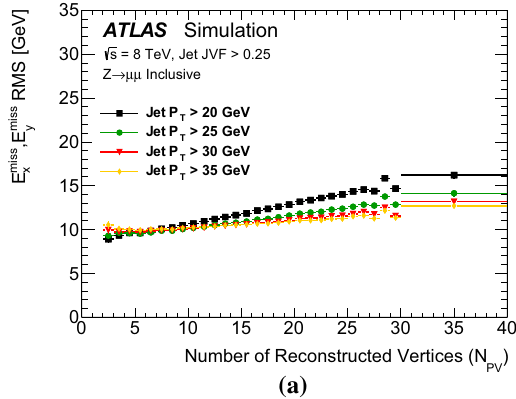
Fig. 19 The a TST E miss resolution as a function of the number of T reconstructed vertices per bunch crossing ( N PV ) and the b TST (cid:3) E miss are shown for different jet- p T thresholds using the direction of the (cid:3) p Z T